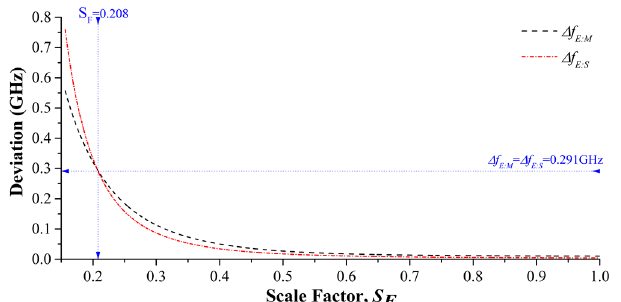
Figure. 9. The Sigmoidal Weibull (type 2) approximations of deviation in measured and simulated resonant frequencies in respect with the theoretical expected values, as describe in (2) and